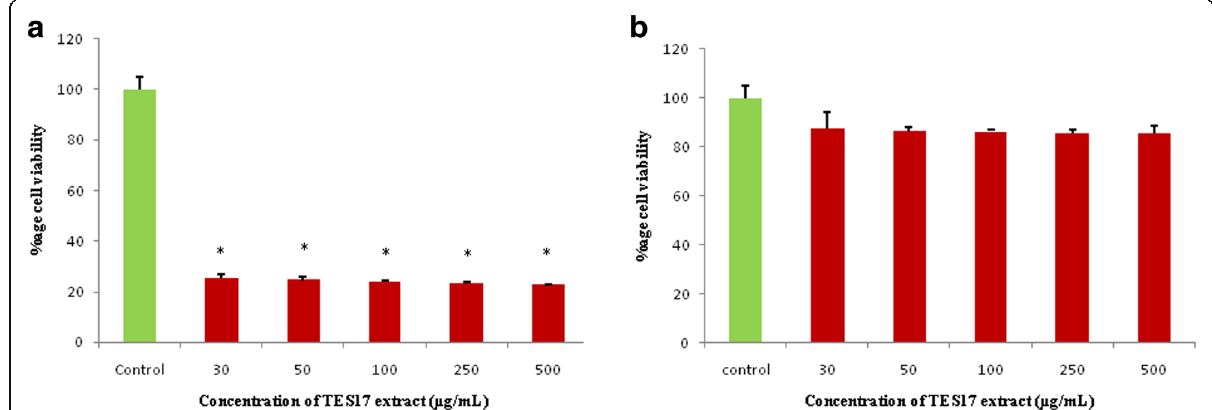
Fig. 5 Effect of TES17 extract against ( a ) cancer cell line and ( b ) normal cell line. The viability of control cells (without TES17 extract) was defined as 100%. Data shown are mean ± SD ( n = 3). * Denotes p ≤ 0.05 between control cells and treated cells